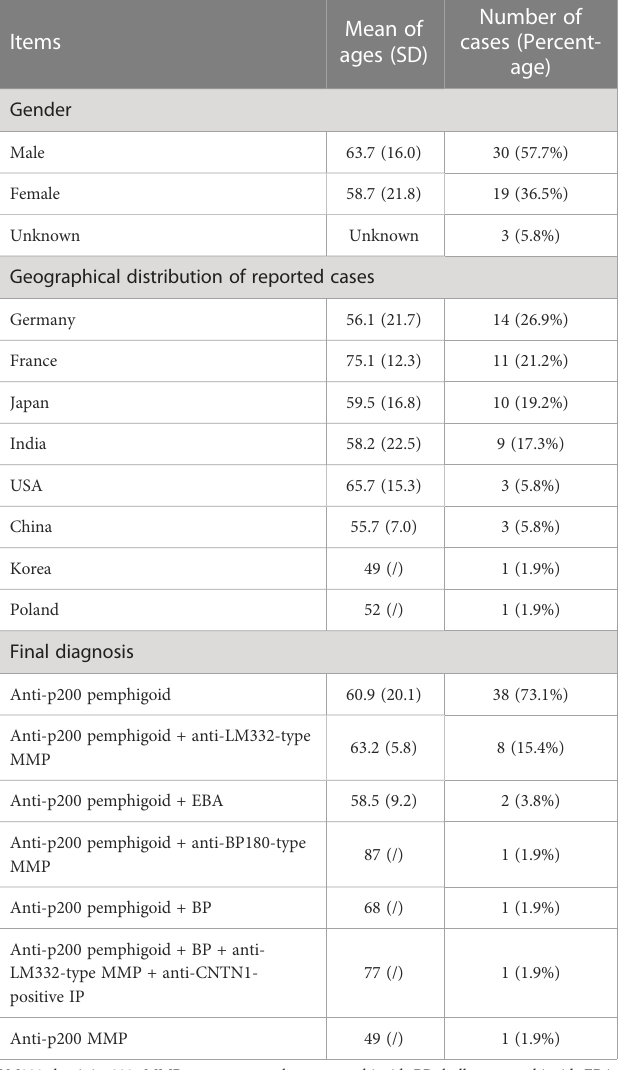
TABLE 1 Demographic characteristics of the 52 cases of anti-p200 pemphigoid with mucosal lesions.